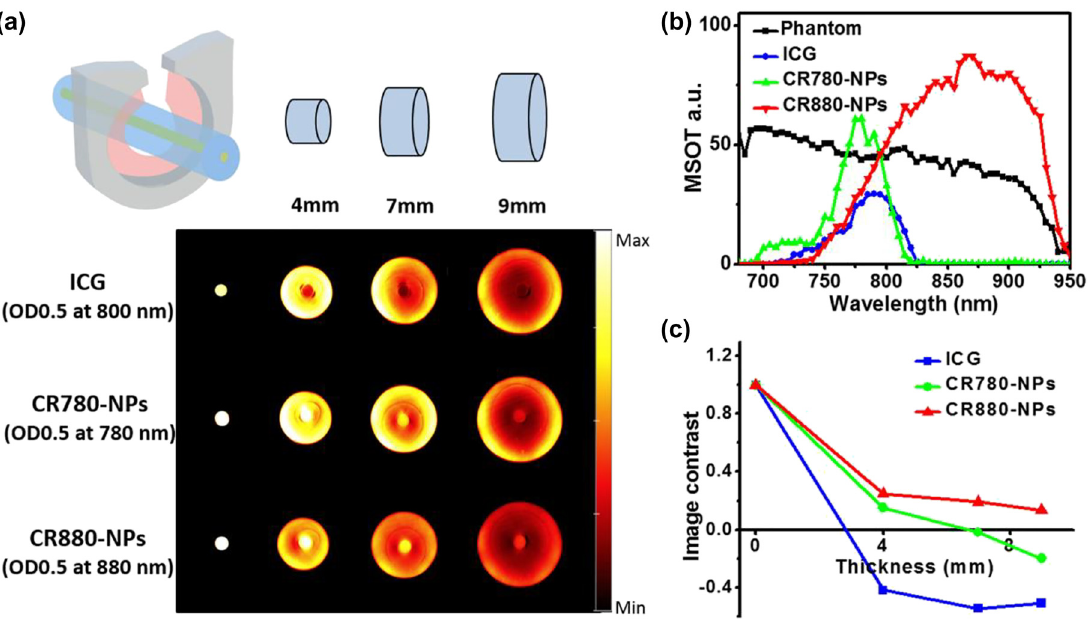
Figure 2: Optoacoustic imaging with CR880-NPs in vitro . (a) Optoacoustic imaging from the center of tissue-mimicking phantoms of increasing thickness containing different samples with the same absorption intensity (0.5) at their absorption peak. The optoacoustic images were individually acquired at their absorption peak as indicated. (b) Optoacoustic signals of ICG, CR780-NPs, and CR880-NPs in the 9 mm phantom. (c) Image contrast of ICG, CR780-NPs, and CR880-NPs in phantoms of different